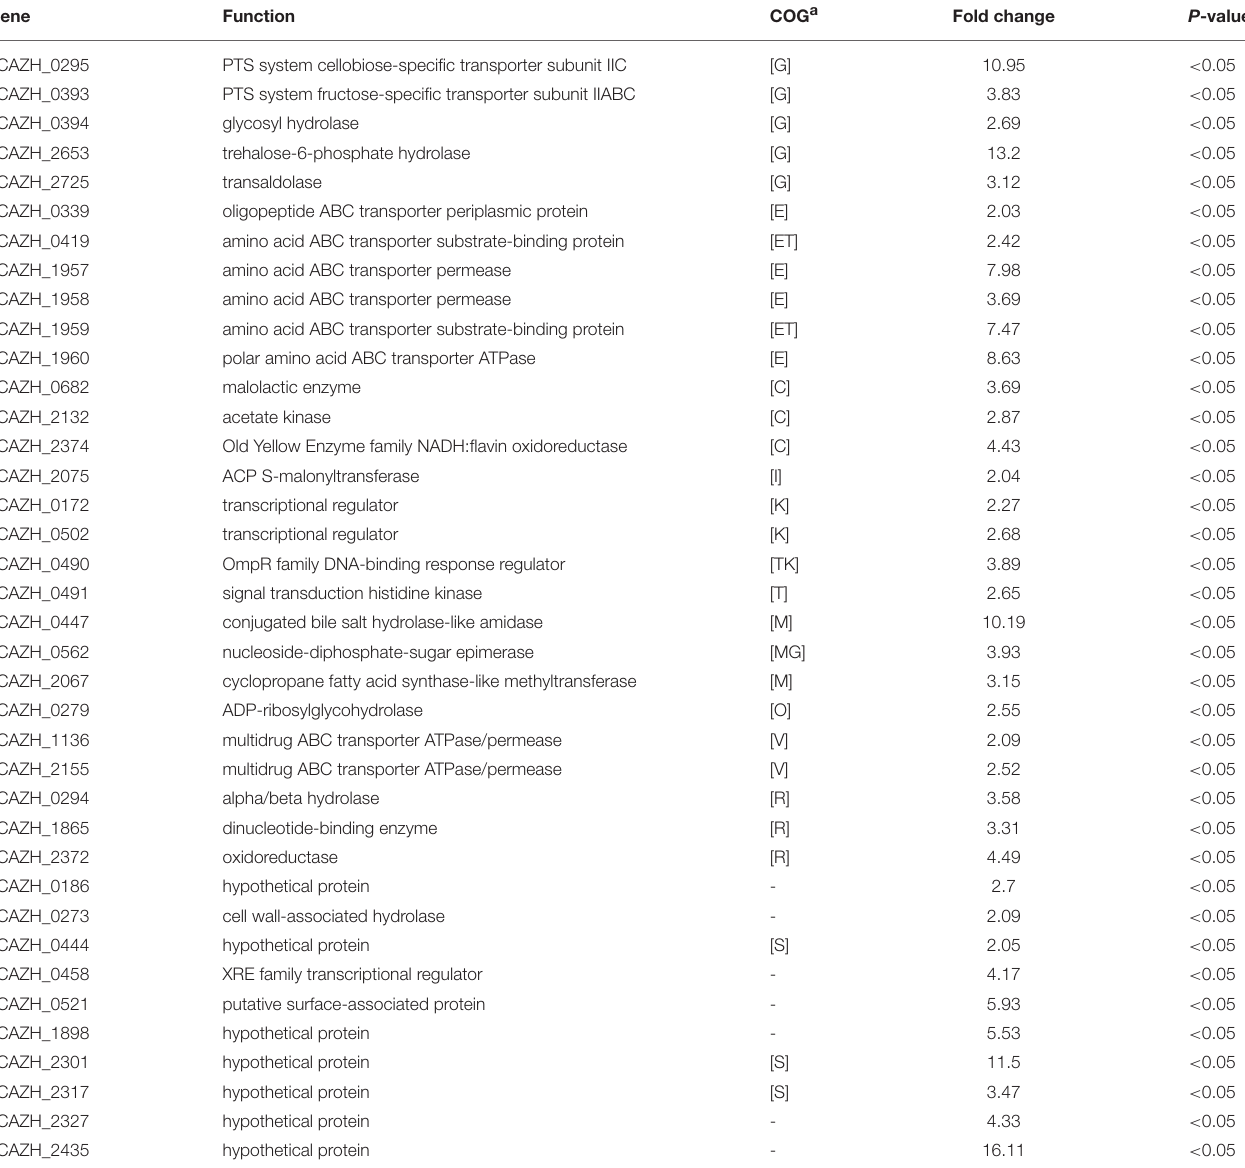
TABLE 2 | Up-regulated Lactobacillus casei Zhang-A-600 proteins in comparison with the parental strain. Gene Function COG a Fold change P -value PTS system cellobiose-specific transporter subunit